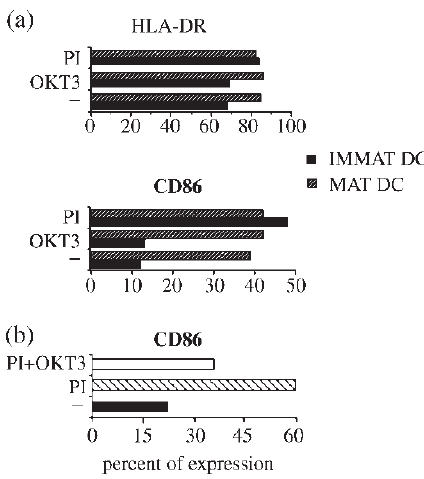
FIGURE 2 Anergic T cells fail to upregulate MHC class II and CD86 molecule expression on “immature” DC cells and inhibit CD86 upregulation induced by responder cells. (a) 2 £ 10 4 “immature” or “mature” DRB1*1101 þ DC, pulsed with HA307-19, were cultured either alone ( 2 ) or with activated F17 (PI) or with F17 anergized on immobilized OKT3 antibody (OKT3) at 37 8 C for 48h. (b) 4 £ 10 4 “immature” DRB1*1101 þ DC pulsed with HA307-19 were cultured either alone ( 2 ) or with activated F17 (PI) or both activated and anergic F17 (PI þ OKT3) (anergic or activated/anergic T cell ratio 3:1) for 48h. Data in (a) and (b), shown as percent of expression of each marker measured by FACS, are from one of two separate experiments.